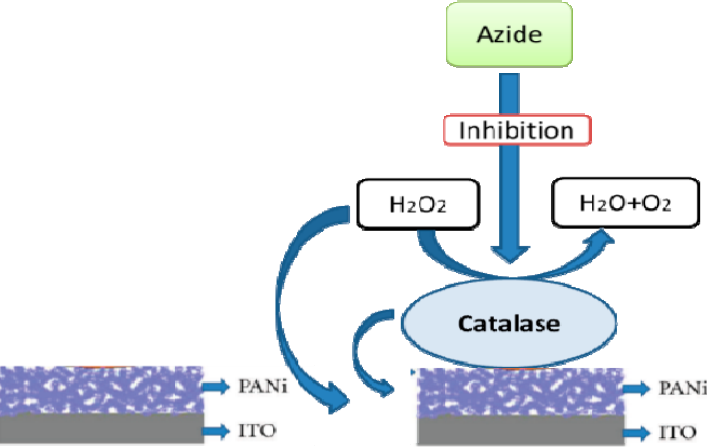
Figure 2. This is a diagrammatic illustration of a bio-electrode to improve the bio-sensor for the hydrogen peroxide grit in an optimal condition. (Singh et al. [2] (Creative Commons Attribution License, which permits unrestricted use, distribution, and reproduction in any medium, provided the original work is properly cited) described a disposable biosensor capable of rapidly detecting not only H 2 O 2 but also azide in biological samples utilizing a CAT/PANi/ITO electrode as a bioelectrode. This film is highly effective at keeping enzyme activity and preventing it from escaping the film. This indicates that this effective film can be used to immobilize not only catalase but also other enzymes and bioactive chemicals, making it a potentially useful platform for the development of biosensors).